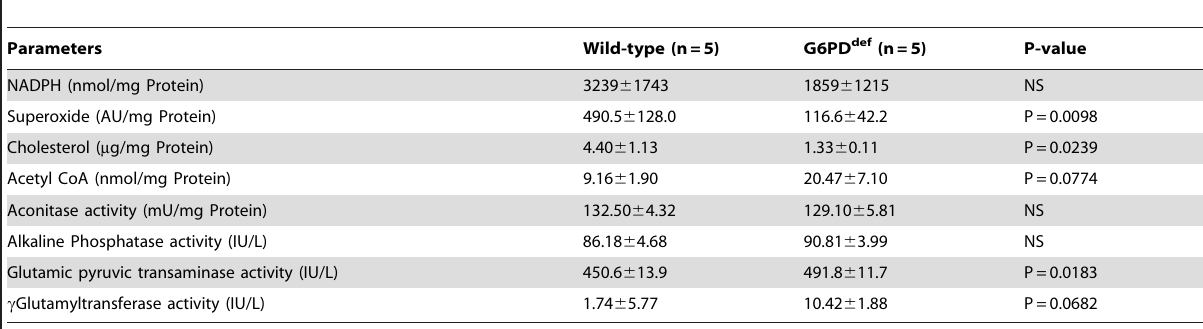
Table 2. NADPH, NADPH-dependent metabolites, and enzyme activity in Glc-6-PD deficient liver.